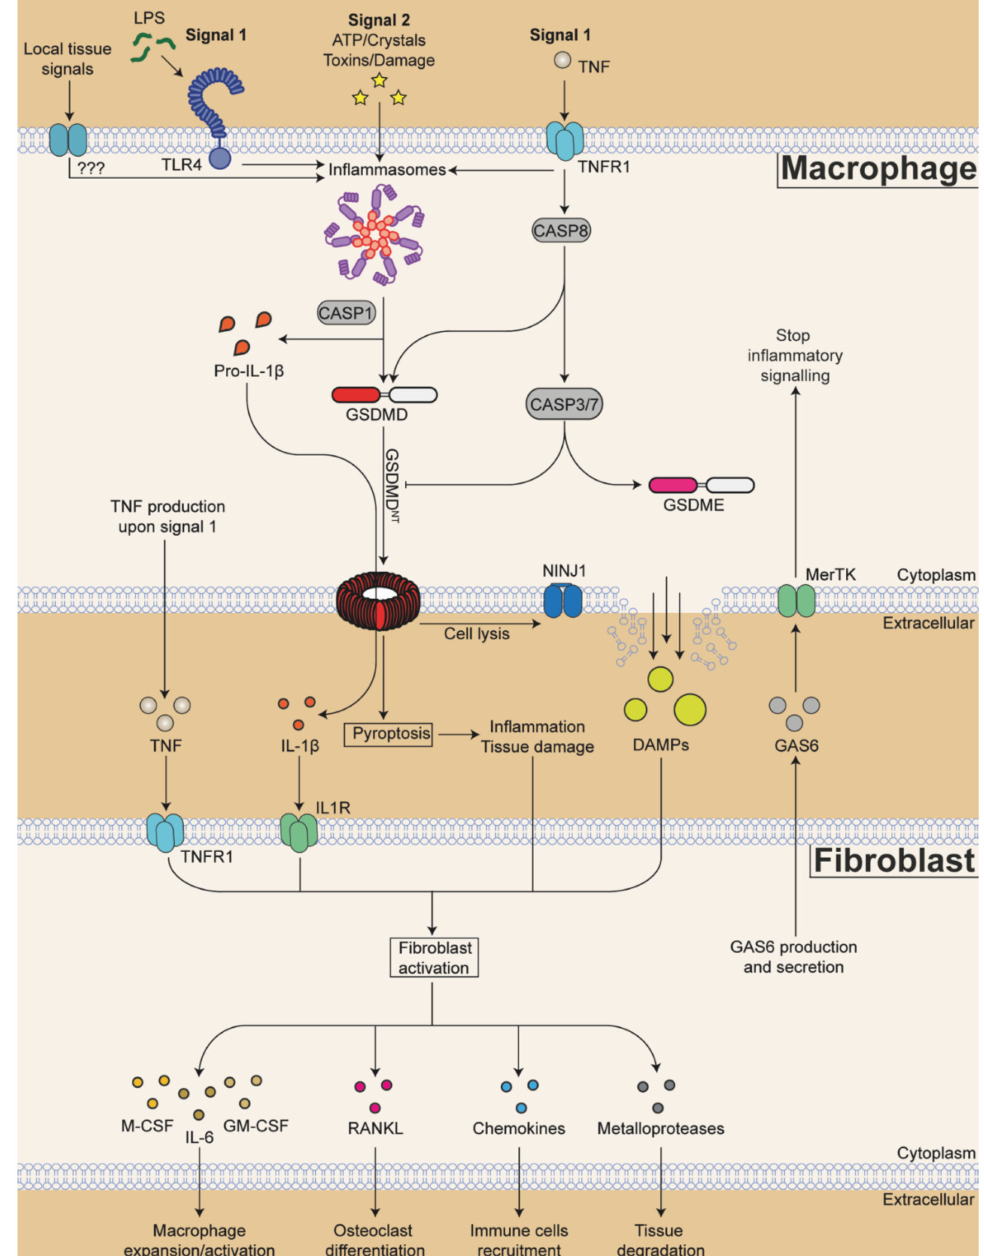
Figure 2. Proposed model of macrophage-fibroblast cross-talk during rheumatoid arthritis. The priming of NLRP3 expression starts with the detection of pathogen- and damage-associated molecular patterns (DAMPs) such as lipopolysaccharide (LPS) and tumour necrosis factor (TNF) (signal 1). Other local tissue signals may be sensed by other receptors that might prime other inflammasomes during rheumatoid arthritis. Inflammasome activation occurs when cells are exposed to a second signal (signal 2) such as high extracellular levels of adenosine triphosphate (ATP) released during tissue damage, bacterial toxins, pathologically accumulated insoluble crystals or other tissue damage signals. Active NLRP3 inflammasome is composed of the sensor NLRP3 (purple), the adapter protein ASC (red) and the effector enzyme caspase-1 (CASP1). Active CASP1 cleaves pro-inflammatory cytokines pro-interleukin (IL)-1 β and pro-IL-18 into their biologically active forms. CASP1 also cleaves the pore-forming protein gasdermin-D (GSDMD), to liberate its N-terminal domain (GSDMD NT , in